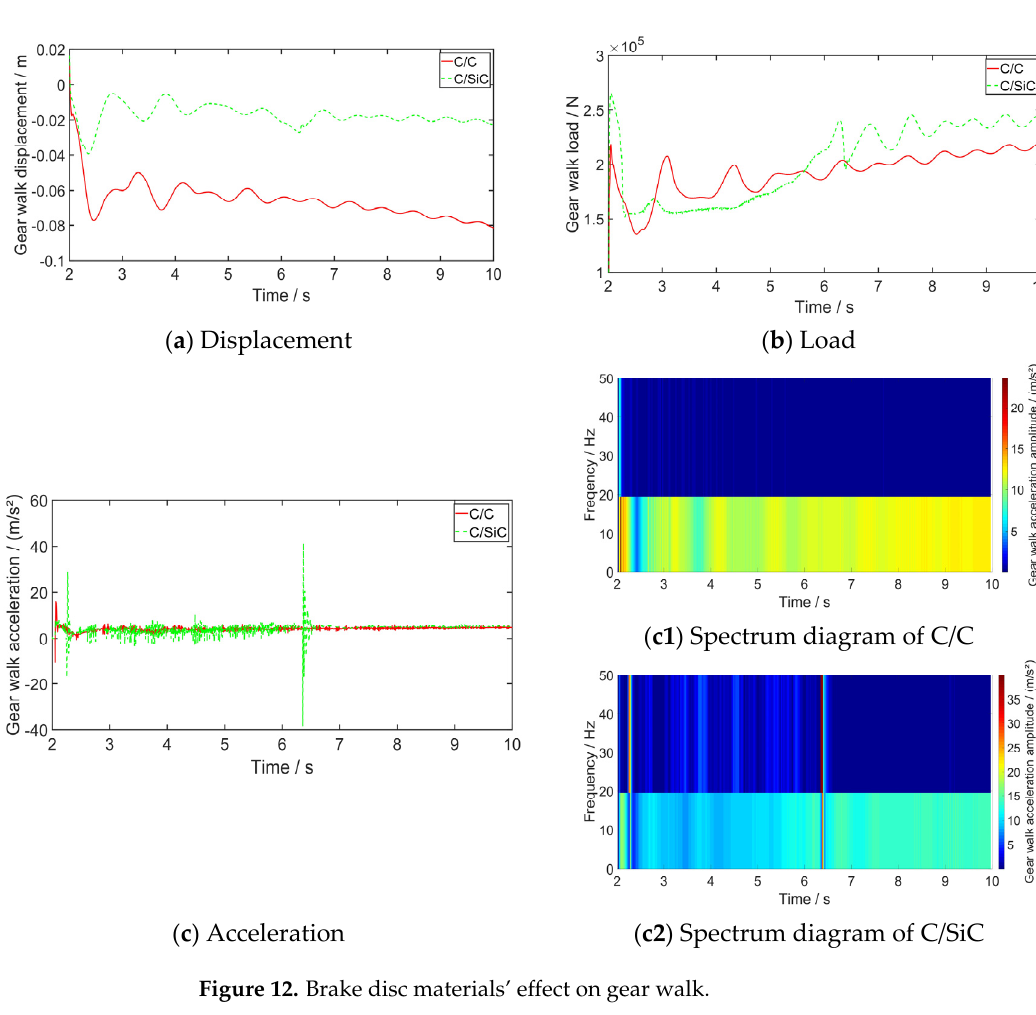
Figure 12. Brake disc materials’ effect on gear walk.